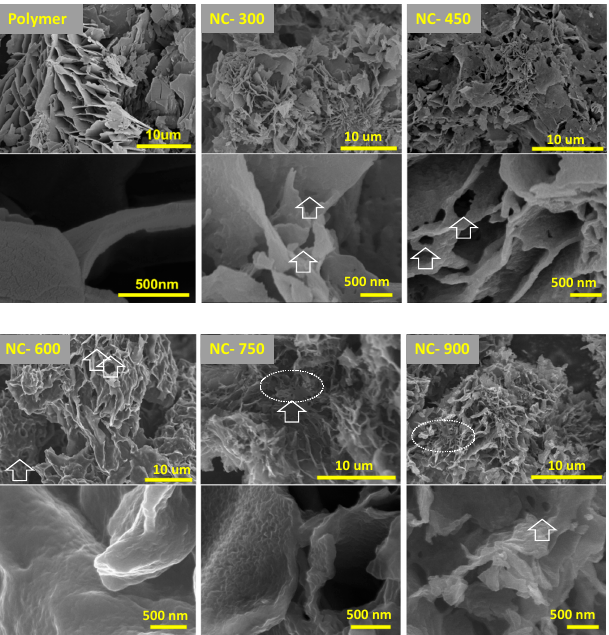
Figure 4. SEM images of PAM crystal and CNs. White arrows and circles indicate the surface defects of CNs.